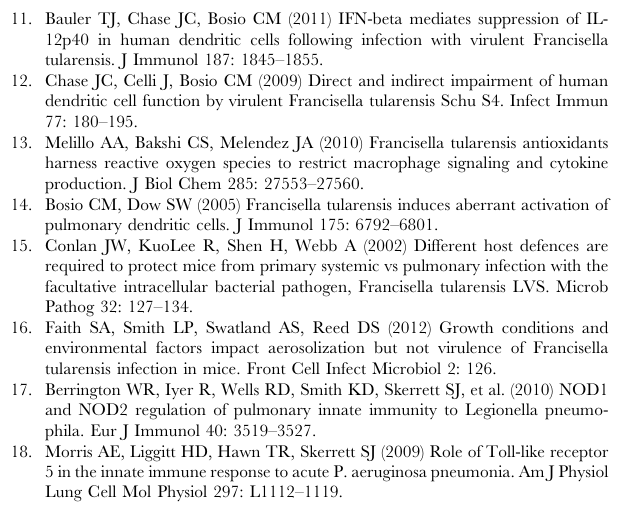
Figure S1 Expression levels of Francisella tularensis genes in mouse lung tissue as measured by qRT-PCR. (EPS) Table S1 Immune-related genes induced during P. aeruginosa but not L. pneumophila infection. Table S2 Immune-related genes induced during Type A F. tularensis infection. Table S3 Francisella -specific mRNA transcripts show- ing decreased abundance between 24 and 48 hrs in lung tissue from infected